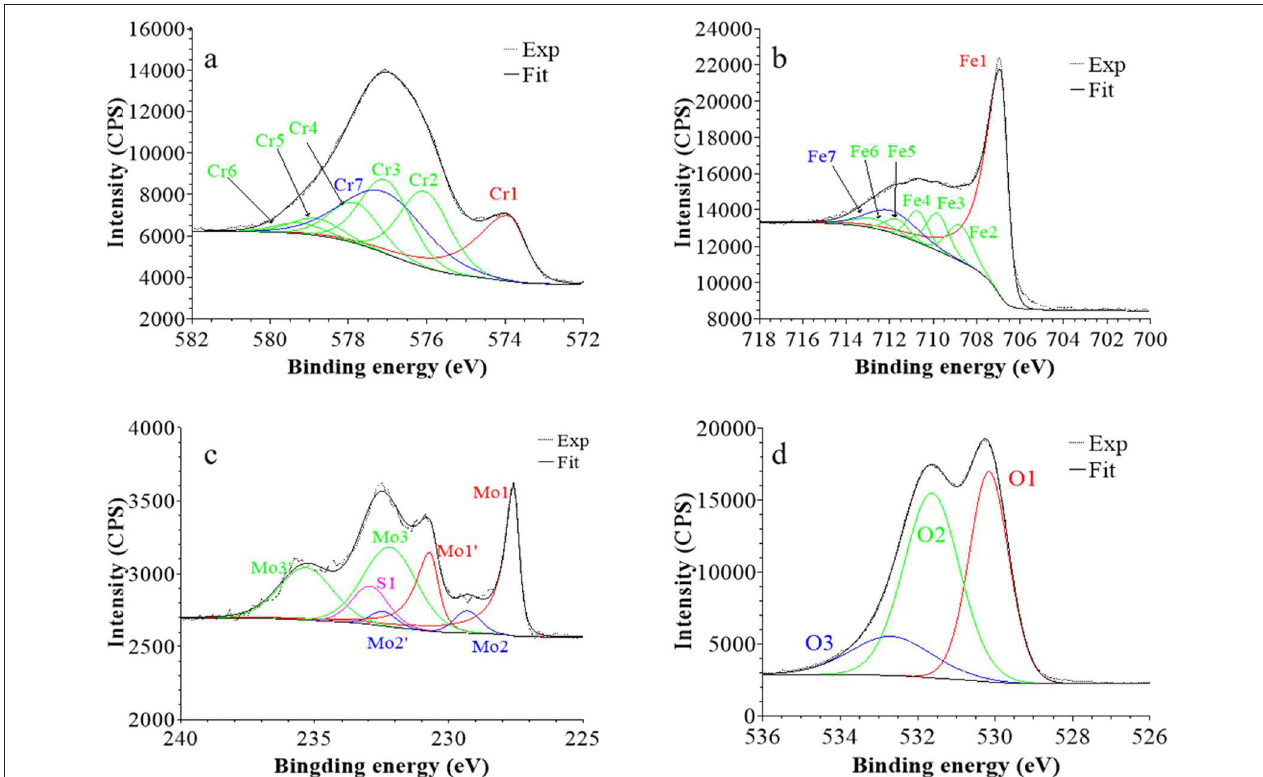
FIGURE 7 | XPS core level spectra and their reconstruction for 316L SS passivated in 0.05M H 2 SO 4 at U PASS = 0.5 V/SCE for 30 min: (a) Cr 2p 3 / 2, (b) Fe 2p 3 / 2, (c) Mo 3d 5 / 2 − 3 / 2, and (d) O 1s regions (take-off angle: 90 ◦